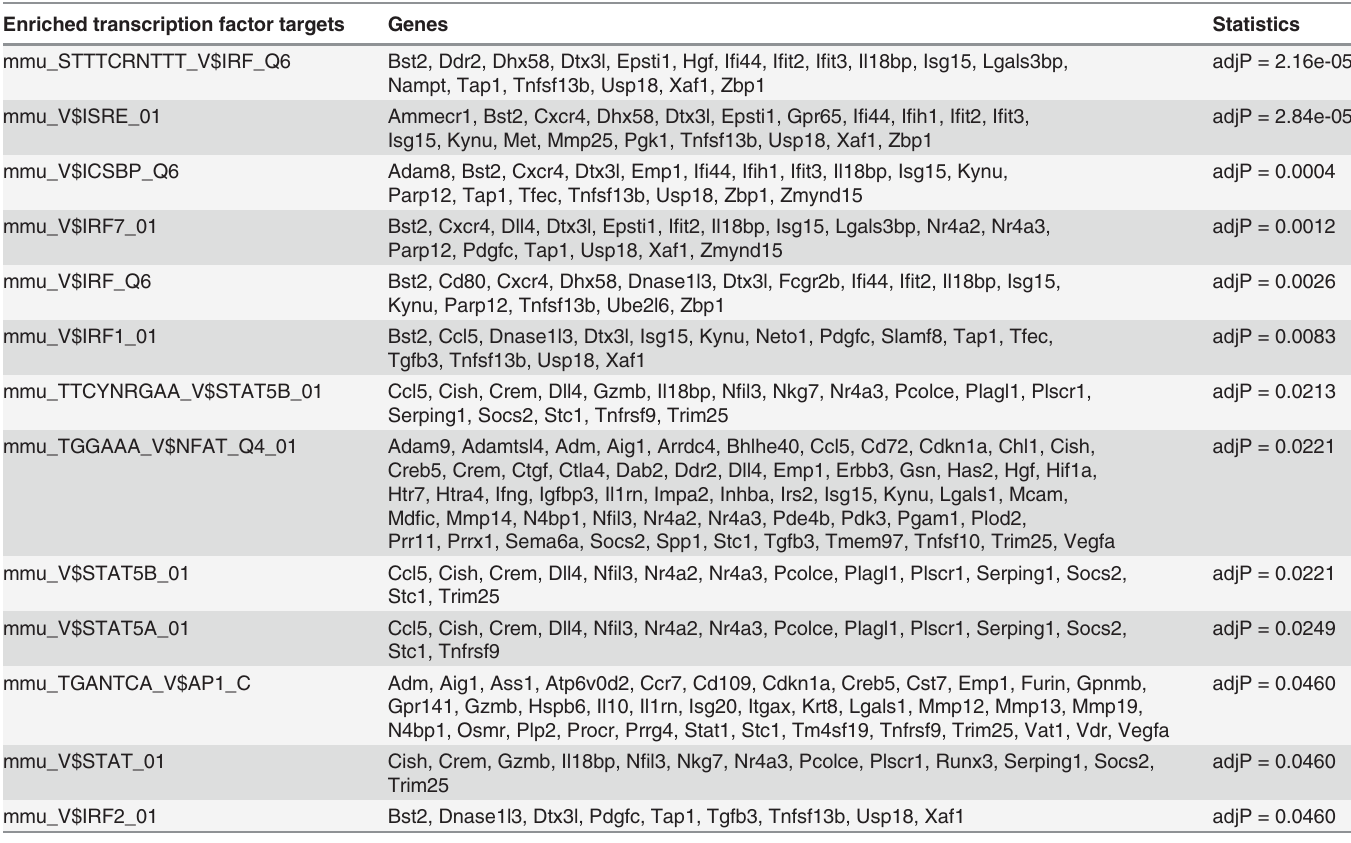
Table 3. We used Webgestalt to identify enriched transcription factor binding sites in > 2 fold upregulated genes in the glioma-regulated (red and brown) modules. Enriched transcription factor targets